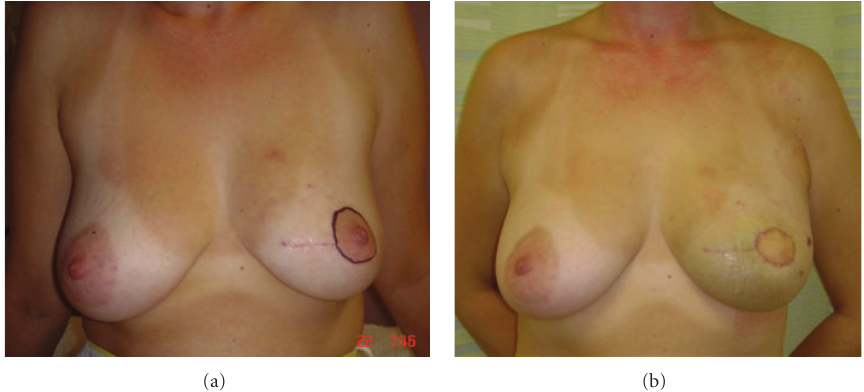
Figure 4: (a) This 41-year-old patient had previously undergone wide local excision of a tumour in the left breast. The lateral margin was involved, necessitating a further central wide local excision to include the nipple-areolar complex. (b) In view of the predicted loss of volume, a latissimus dorsi miniflap was utilised to both fill the resultant defect and also replace the skin of the areola. The volume of the partially reconstructed breast is very similar to that of the contralateral side, although postoperative swelling is apparent.